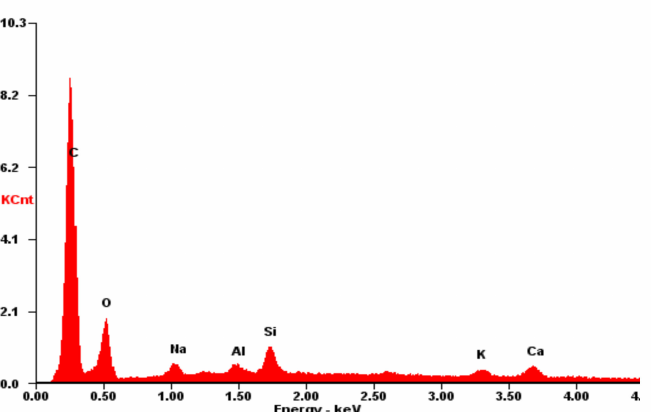
Figure 8. The EDS spectrum recorded for the textolite material with evidently marked degradation effects. The contents of the elements present in fibreglass textile support (silicon, calcium, aluminium, potassium and sodium) are clearly visible.